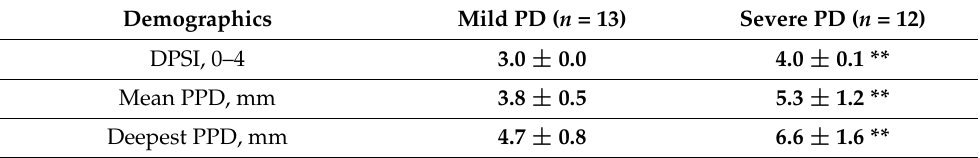
Table 1. Baseline characteristics. Demographics are reported as mean ± SD or (number of partic- ipants). Circulating cytokines and chemokines are reported as median (IQR). One sample’sIL-6 concentration was under the detection limit of 0.70 pg/mL. Periodontal inflammation is reported as mean ± SD. Demographics were compared using the independent samples T-test (continuous normally distributed variables) and X 2 test (categorical variables). Circulating cytokines, chemokines, and periodontal inflammation were compared using one-way ANCOVA while accounting for partici- pant age. ˆ: p < 0.10, *: p < 0.05, **: p < 0.01. PPD: probing pocket depth, WBC: white blood cell count, SUV: standard uptake value of periodontal [ 18 F] FDG-uptake on [ 18 F]FDG PET/CT scan.